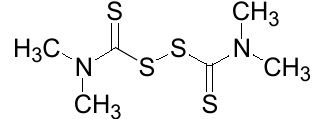
Figure 1: Structure of thiram.